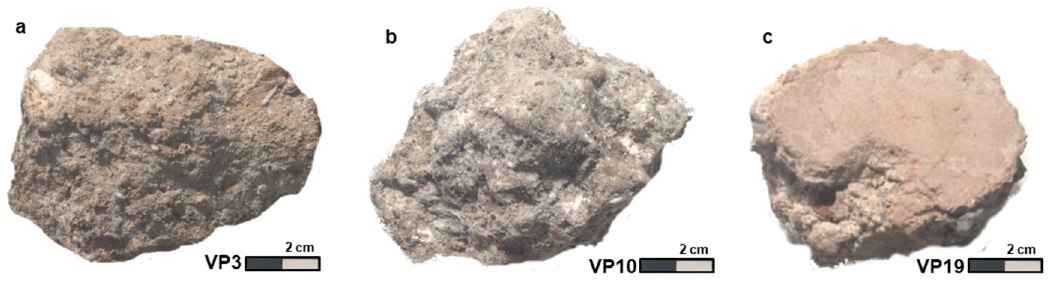
Figure 4. Some representative mortar samples from archaeological sites; ( a ) VP3 bedding mortar sample (group A); ( b ) VP10 bedding mortar sample (group B); ( c ) VP19 floor mortar sample (group